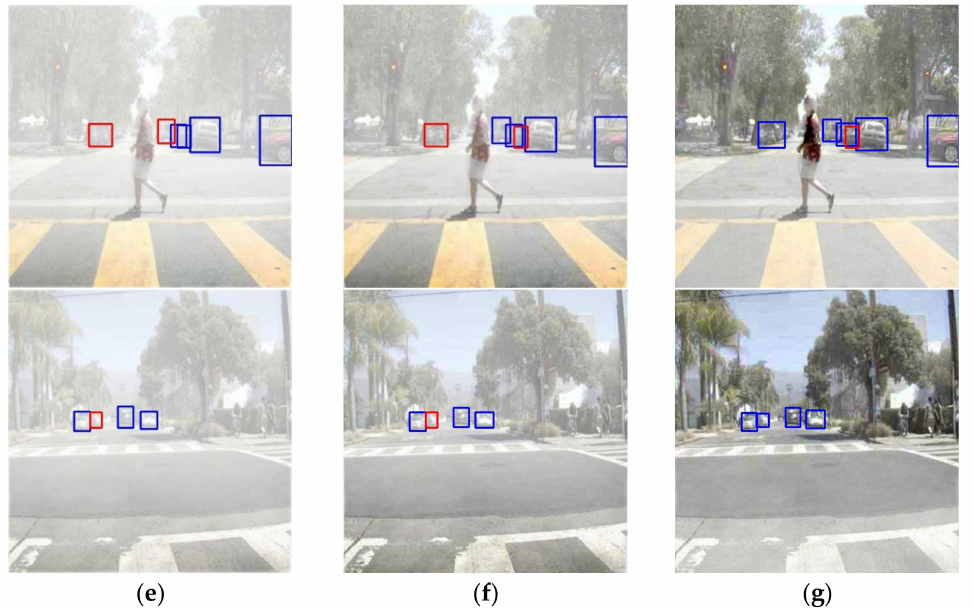
Figure 6. Examples of vehicle detection results via model under reduced visibility (Red box—Missed detection, Blue box—Correct detection); ( a ) YOLO R , ( b ) YOLO T , ( c ) YOLO RT , ( d ) YOLO R + [33], ( e ) YOLO R + [24], ( f ) YOLO R + [23], ( g ) YOLO RT +